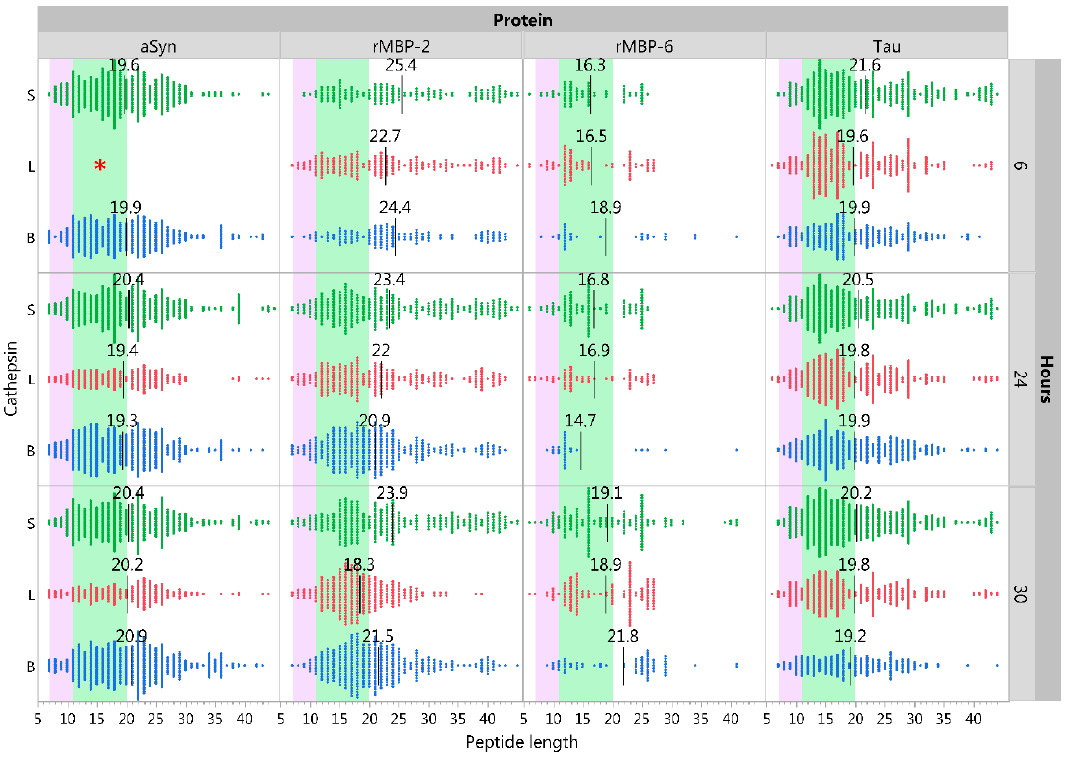
Figure 1. Peptide lengths resulting from in vitro cathepsin digestion of central nervous system proteins. Distribution of peptide lengths after digestion of alpha-synuclein (aSyn), recombinant myelin basic protein (rMBP) isoforms 2 and 6, and tau with either cathepsin B, L, or S at 6, 24, or 30 h at pH 6. Each data point represents one identified peptide at the given time point. Black lines with annotations indicate the mean size of peptides. Purple and green areas indicate peptide sizes fitting HLA class I and II, respectively. * aSyn 6-h sample for cathepsin L was lost due to technical error.